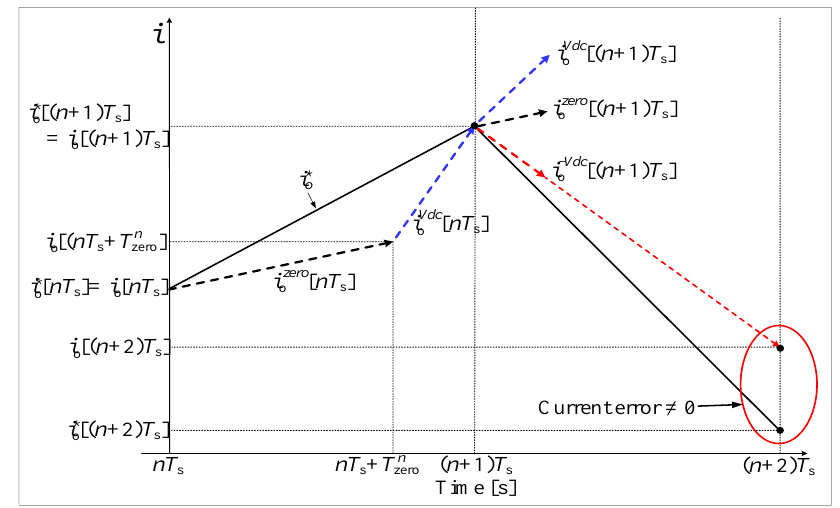
Figure 5. Current behaviors with step change of reference current during a transient response.